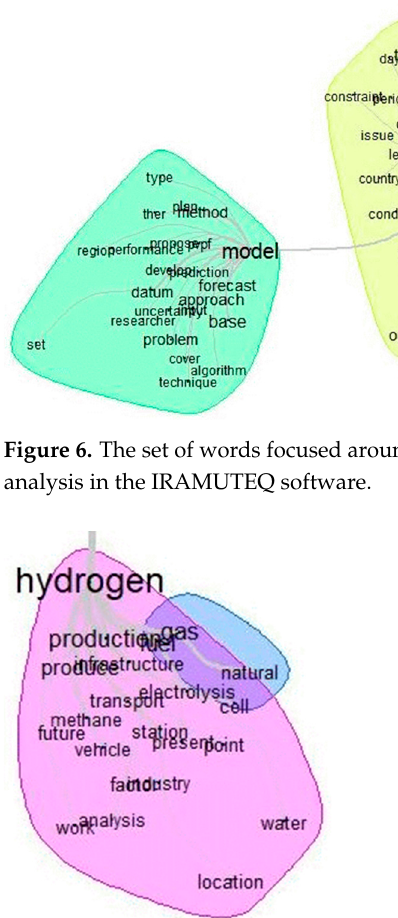
10 of 25 Figure 5. The set of words focused around the word “energy”. Source: own elaboration based on an analysis in the IRAMUTEQ software.